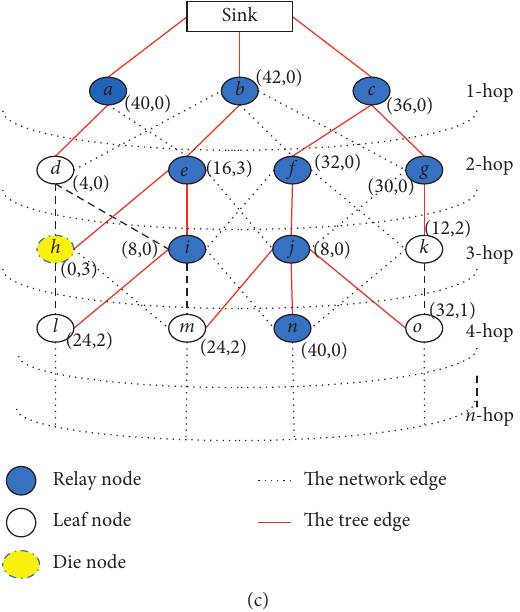
Figure 5: Load-balancing method of the nodes in heterogeneous